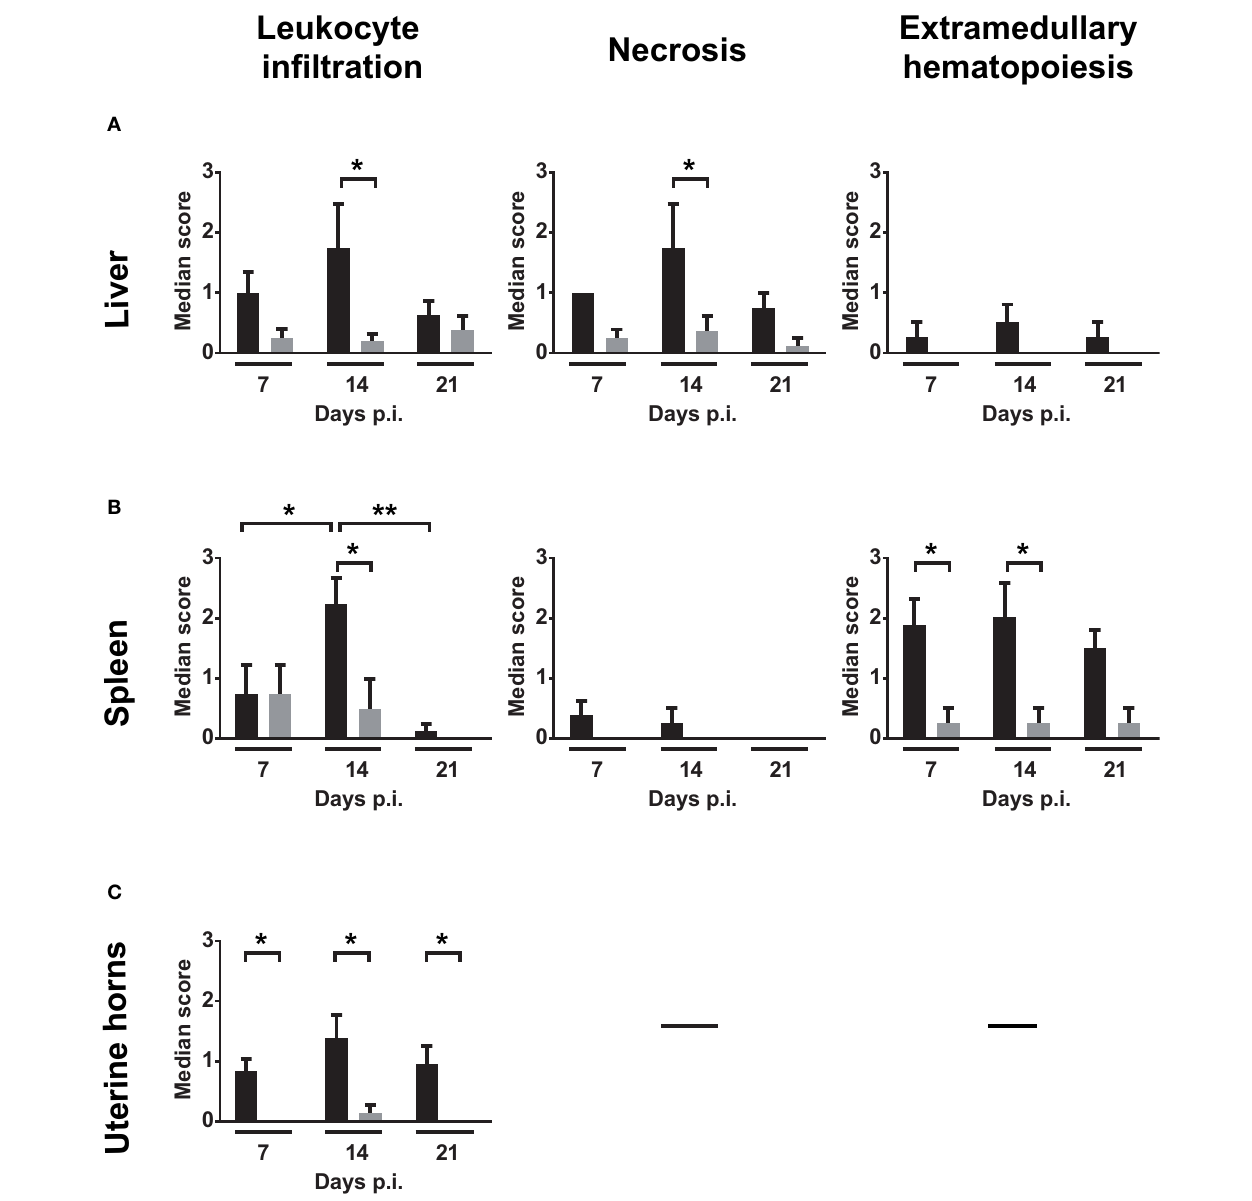
FIGURE 4 | Median severity scores of spleen, liver and uterine horn pathology and leukocyte infiltration. Liver, spleen, and uterine horn tissues of infected mice and mock were collected at days 7, 14, and 21 p.i. and analyzed for histopathological changes by H&E staining under light microscope. Severity scores (1–4) of inflammatory cell infiltrates, necrosis and EMH are shown for (A) liver, (B) spleen, and (C) uterine horns. Scores are representative of four individual mice. Groups were compared using the Mann–Whitney rank sum test. The level of significance is depicted as * P < 0.05 ; ** P < 0.01 . genital mouse infection model and since W. chondrophila is closely related to C. trachomatis , we used a semi-rigid cannula per vaginam to pass the cervix and injected live freshly